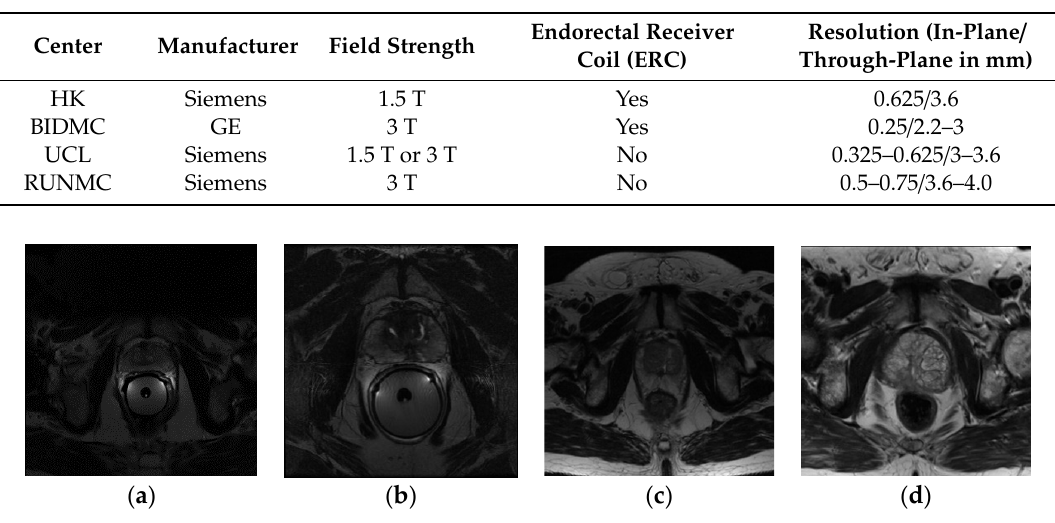
Figure 1. Example image slices from PROMISE12 dataset; ( a ) 1.5 T with ERC from HK; ( b ) 3.0 T with ERC from BIDMC; ( c ) 1.5 T without ERC from UCL; ( d ) 3.0 T without ERC from RUNMC.